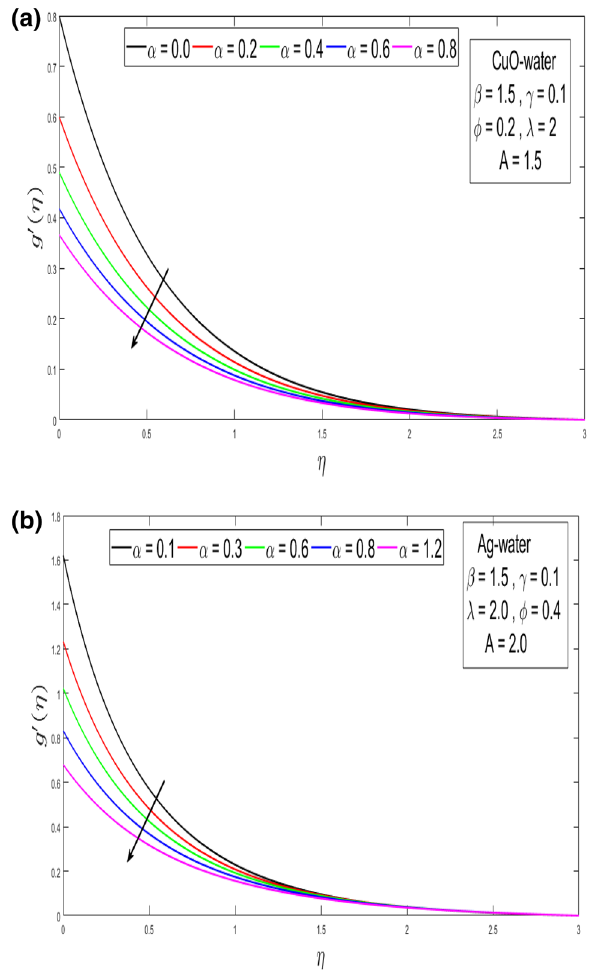
Figure 3. ( a ) Outcome of velocity slip α parameter over the velocity distribution g ′ (η) for CuO nanoparticle. ( b ) Outcome of velocity slip α parameter above the velocity distribution g ′ (η) for Ag